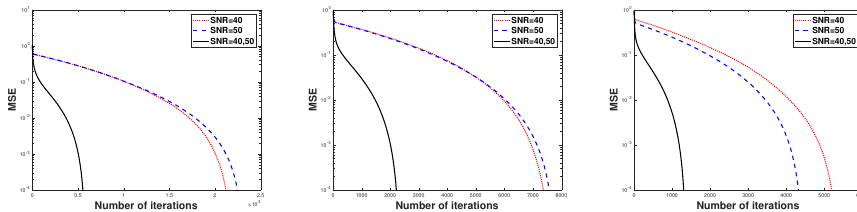
Figure 8. Graph of number of iterations versus Error where N = 512 and M = 265.